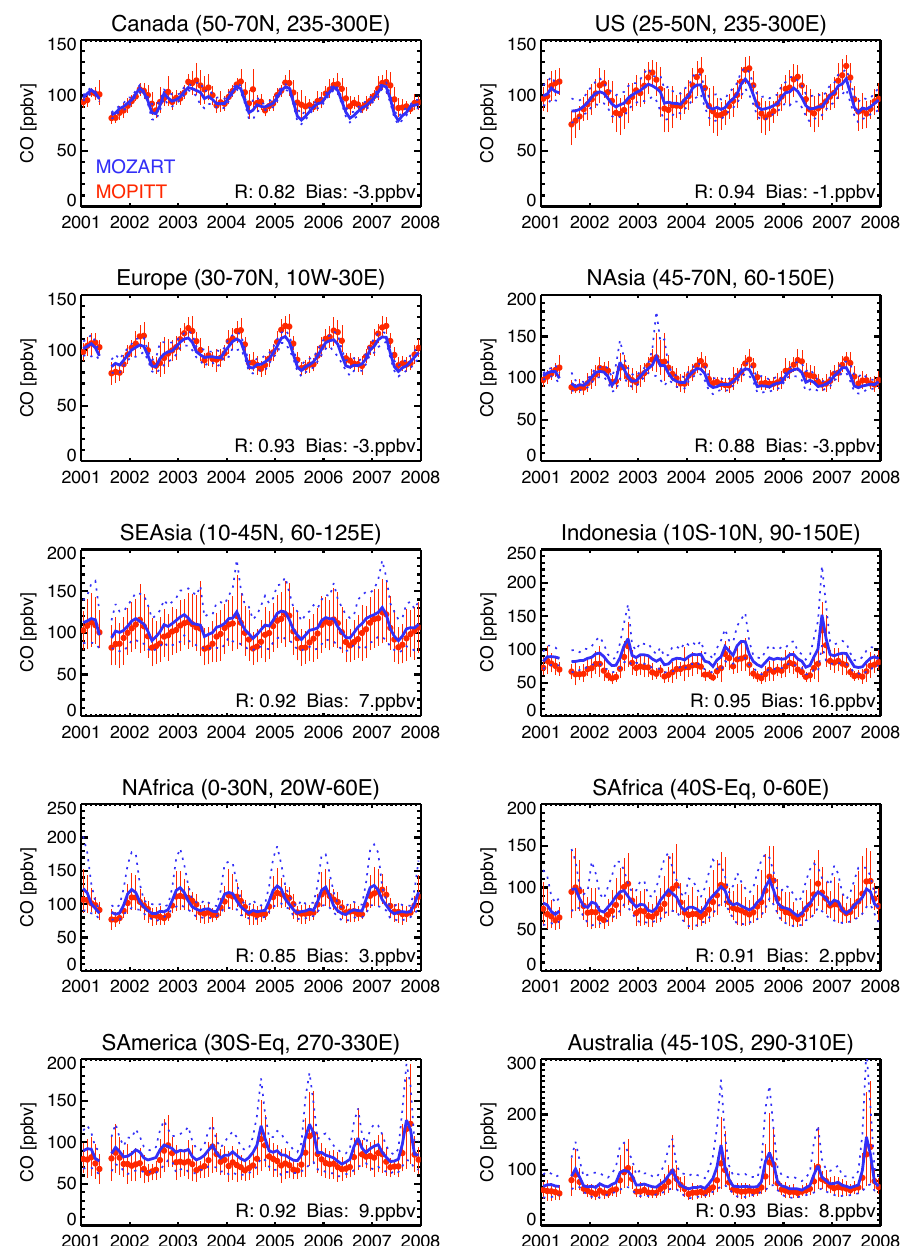
Fig. 7. Comparison of MOZART-4 CO (blue solid and dashed lines) with MOPITT V4 CO (red points and error bars) averaged over regions, based on column averages of monthly means. MOZART-4 results have been transformed with the MOPITT averaging kernels and a priori. The error bars (and dashed lines for MOZART-4) indicate the 10th to 90th percentiles of the range of data over the region for each